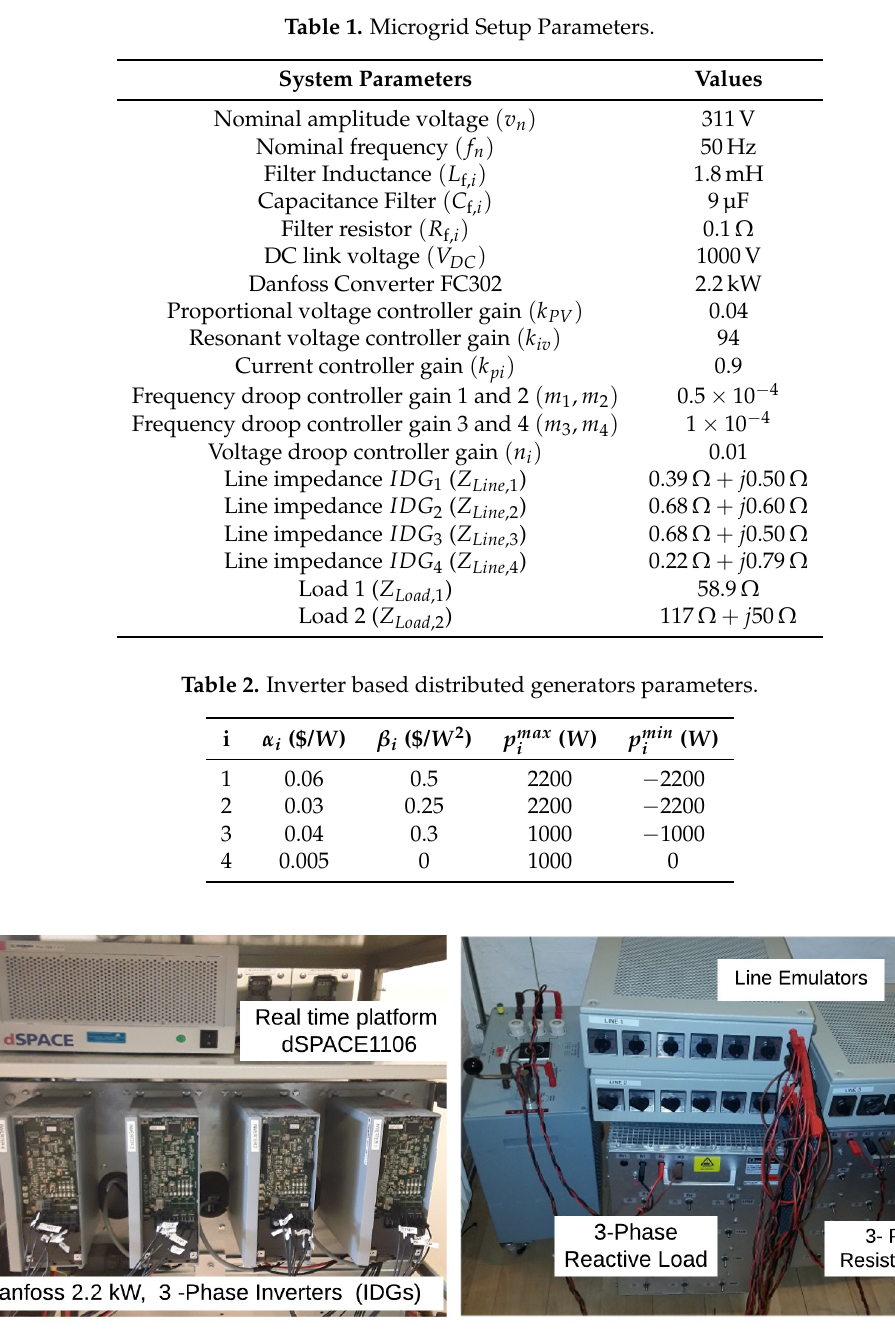
Figure 6. Experiment